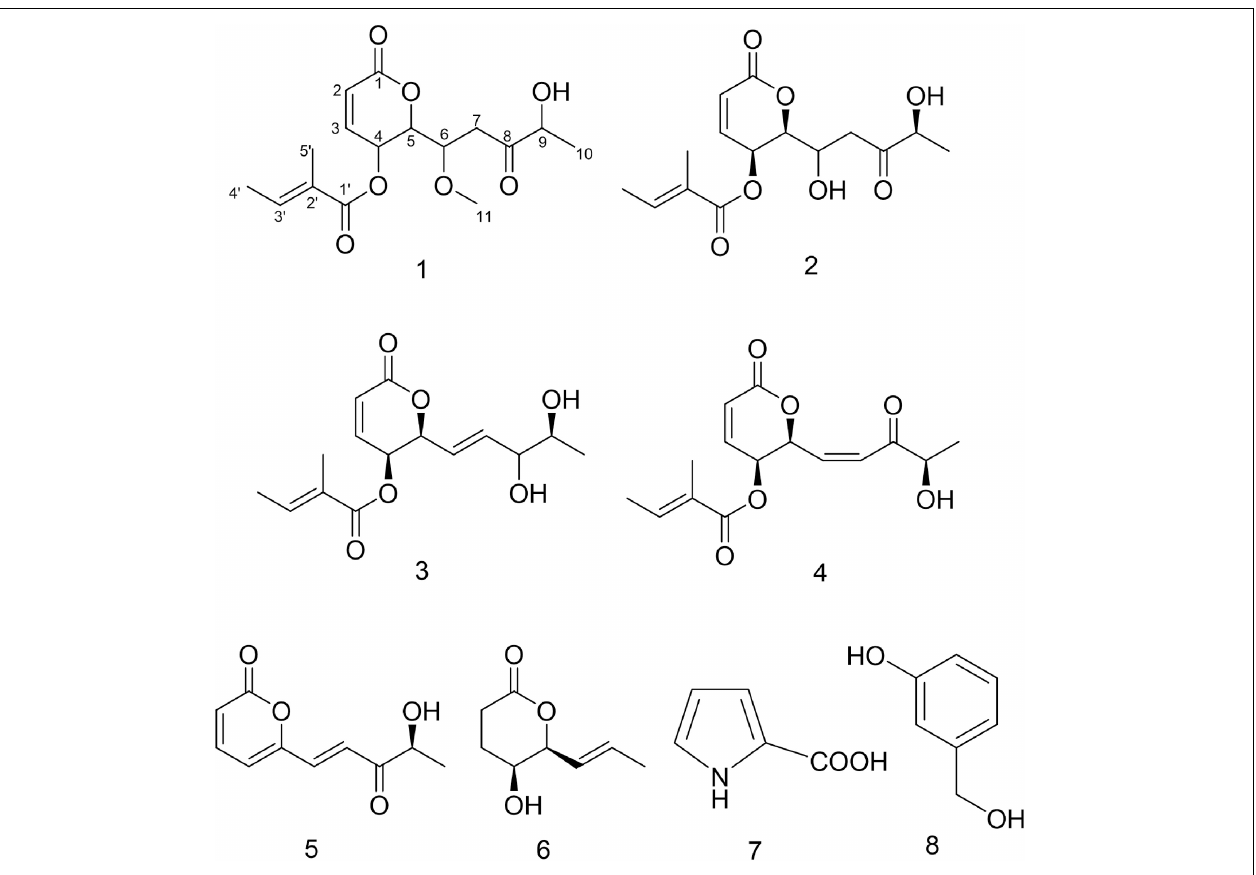
FIGURE 5 | Structures of compounds 1–8